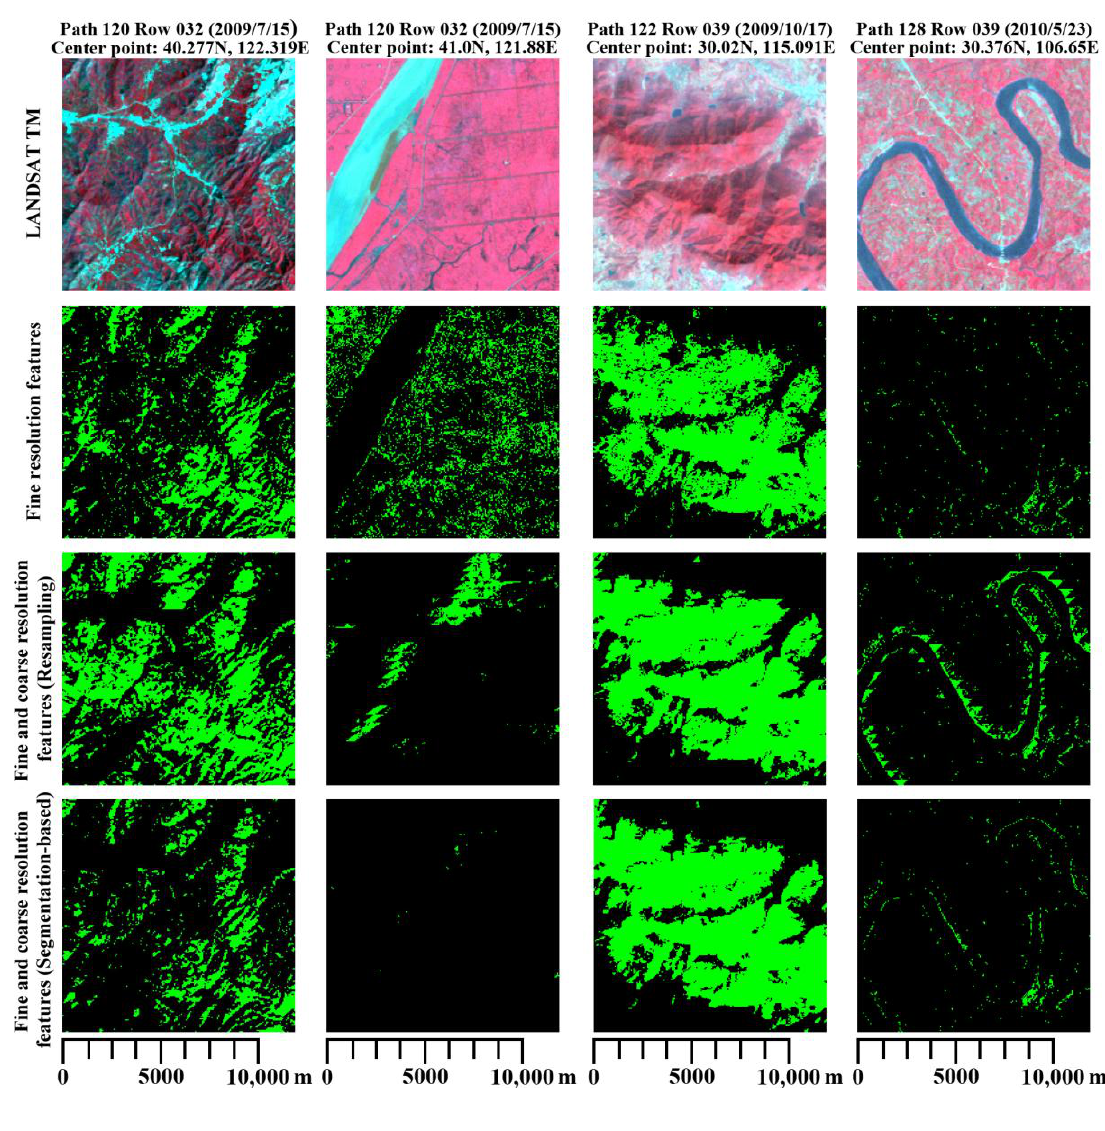
Figure 5. Selected case comparison of the resolution influences (Green color represents forest and black represents non-forest.) From left to right, the image segments were selected from Liaoning Province, Liaoning Province, Hubei Province, and Sichuan